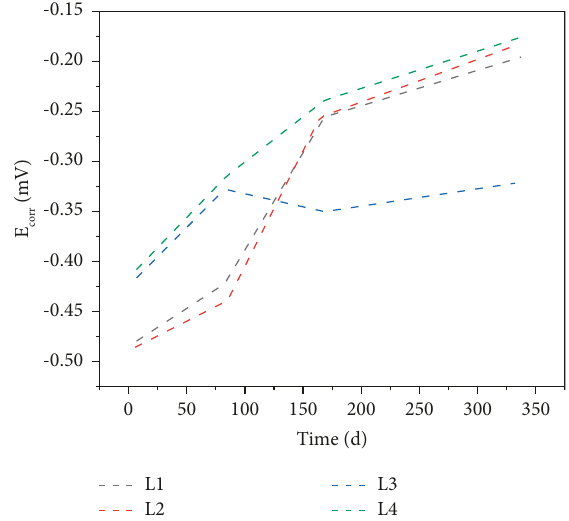
Figure 3: Change of self-corrosion potential of reinforcement with time.